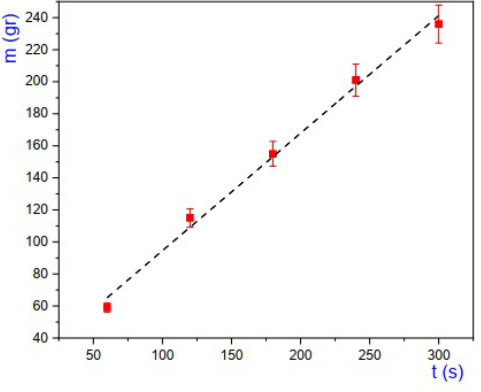
Figure 4. Plot of the added mass, as a function of time, into a cold, distilled water reservoir produced with the minimum aperture of the steam generator. In this case, the steam nozzle produced a mass · m = 0.66 ± 0.03 gr/s. flow rate equal to